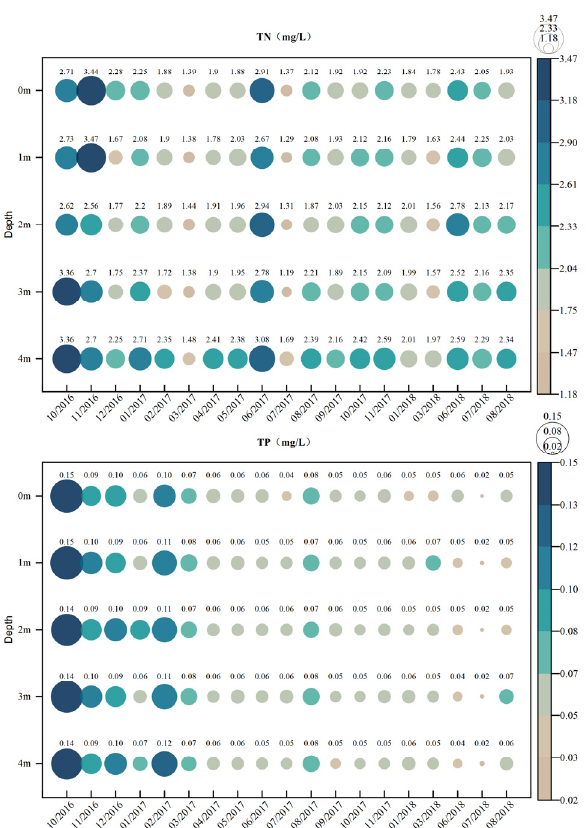
Figure 7. The change in TN and TP concentration in Lake Yilong from October 2016 to August 2018.